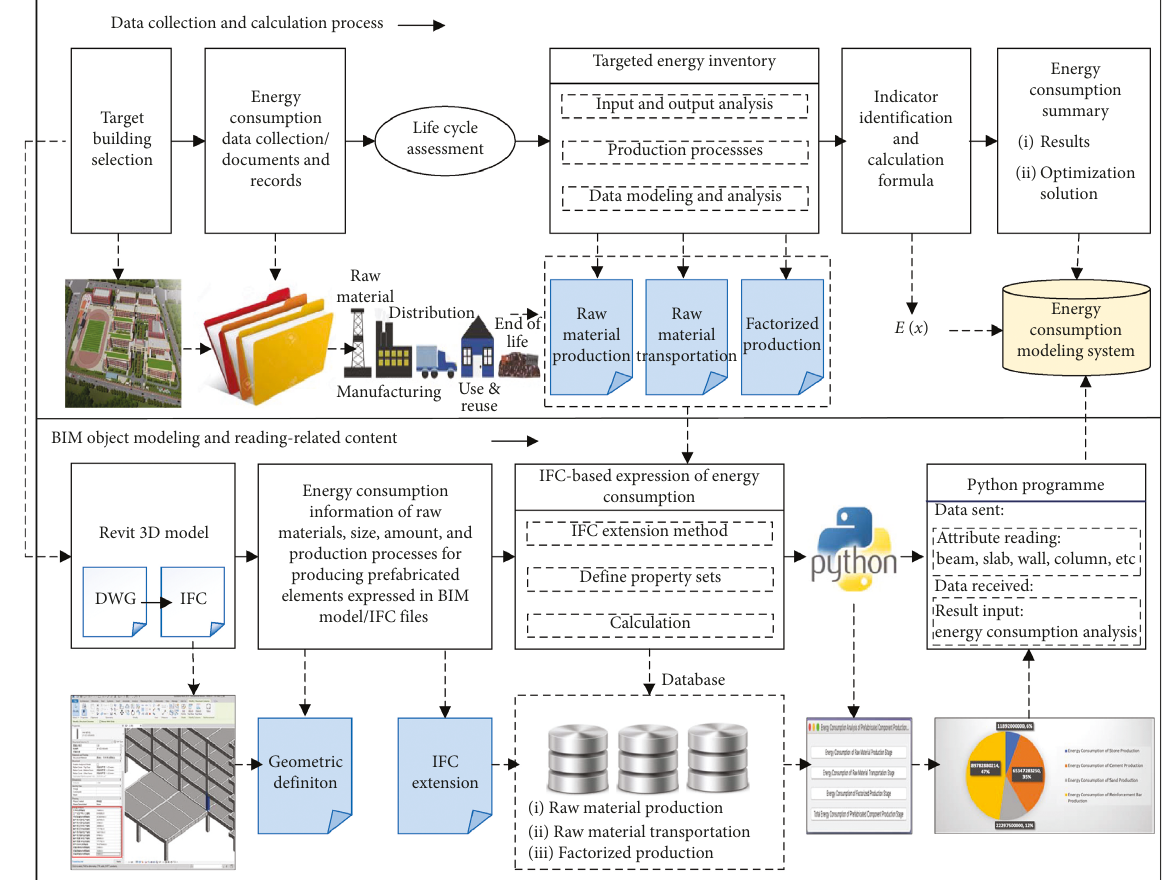
Figure 1: The integrated approach for energy analysis of prefabricated